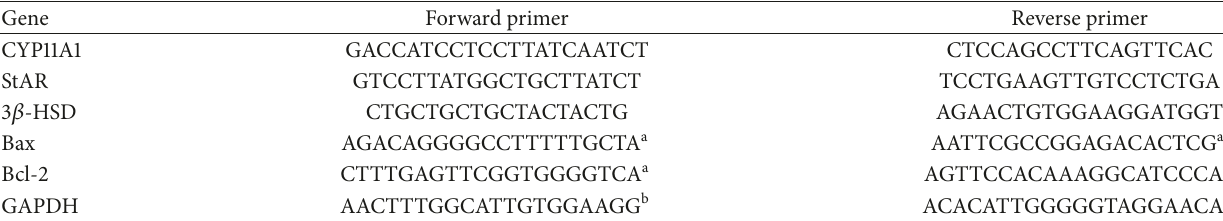
Table 1: Primers are used for real-time PCR analysis.